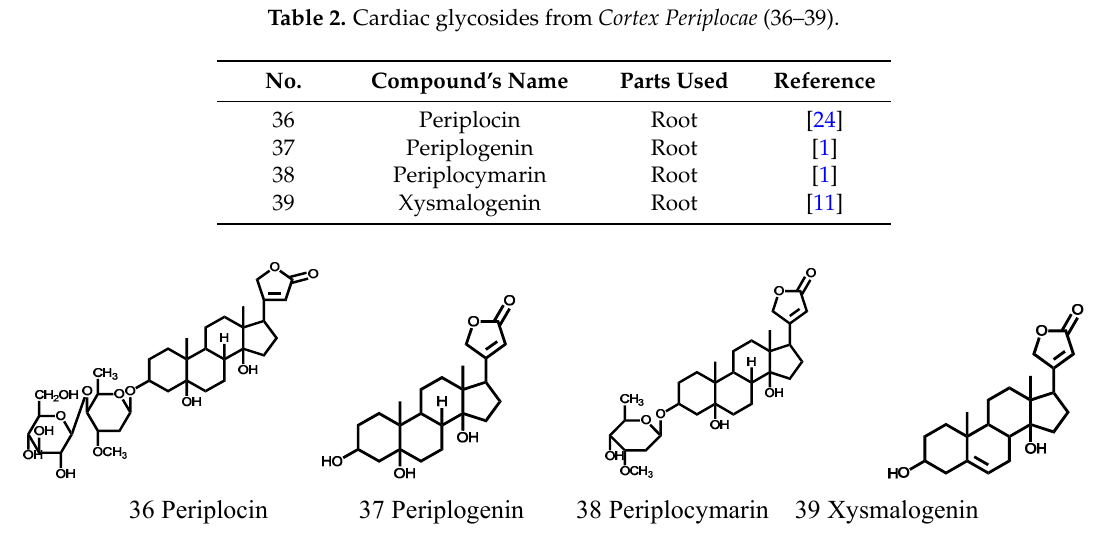
Figure 2. The structures of Cardiac glycosides (36–39) obtained from Cortex Periplocae .